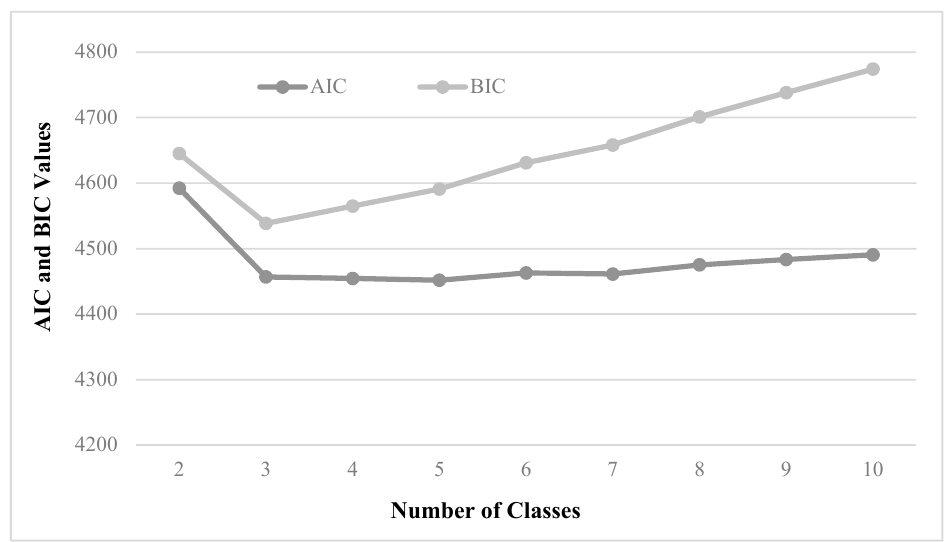
Figure 2. The information criteria (AIC and BIC) used in determining number of the classes in the Latent Class Model (LCM). AIC: Akaike Information Criterion, BIC: Bayesian Information Criterion.